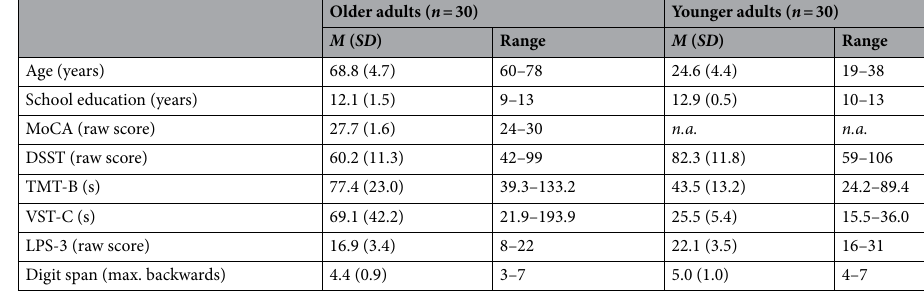
Table 1. Characteristics of participants and cognitive results. MoCA Montreal Cognitive Assessment, DSST Digit Symbol Substitution Test, WAIS-IV; TMT-B , Trail Making Test, part B, VST-C Victoria Stroop Test colour naming, LPS-3 LPS intelligence scale, subtest 3, logical reasoning; M : mean; SD : standard deviation; n.a. not assessed; where applicable, comparisons between older and younger adults using t -tests yielded significant differences in the reported measures, all p’ s ≤